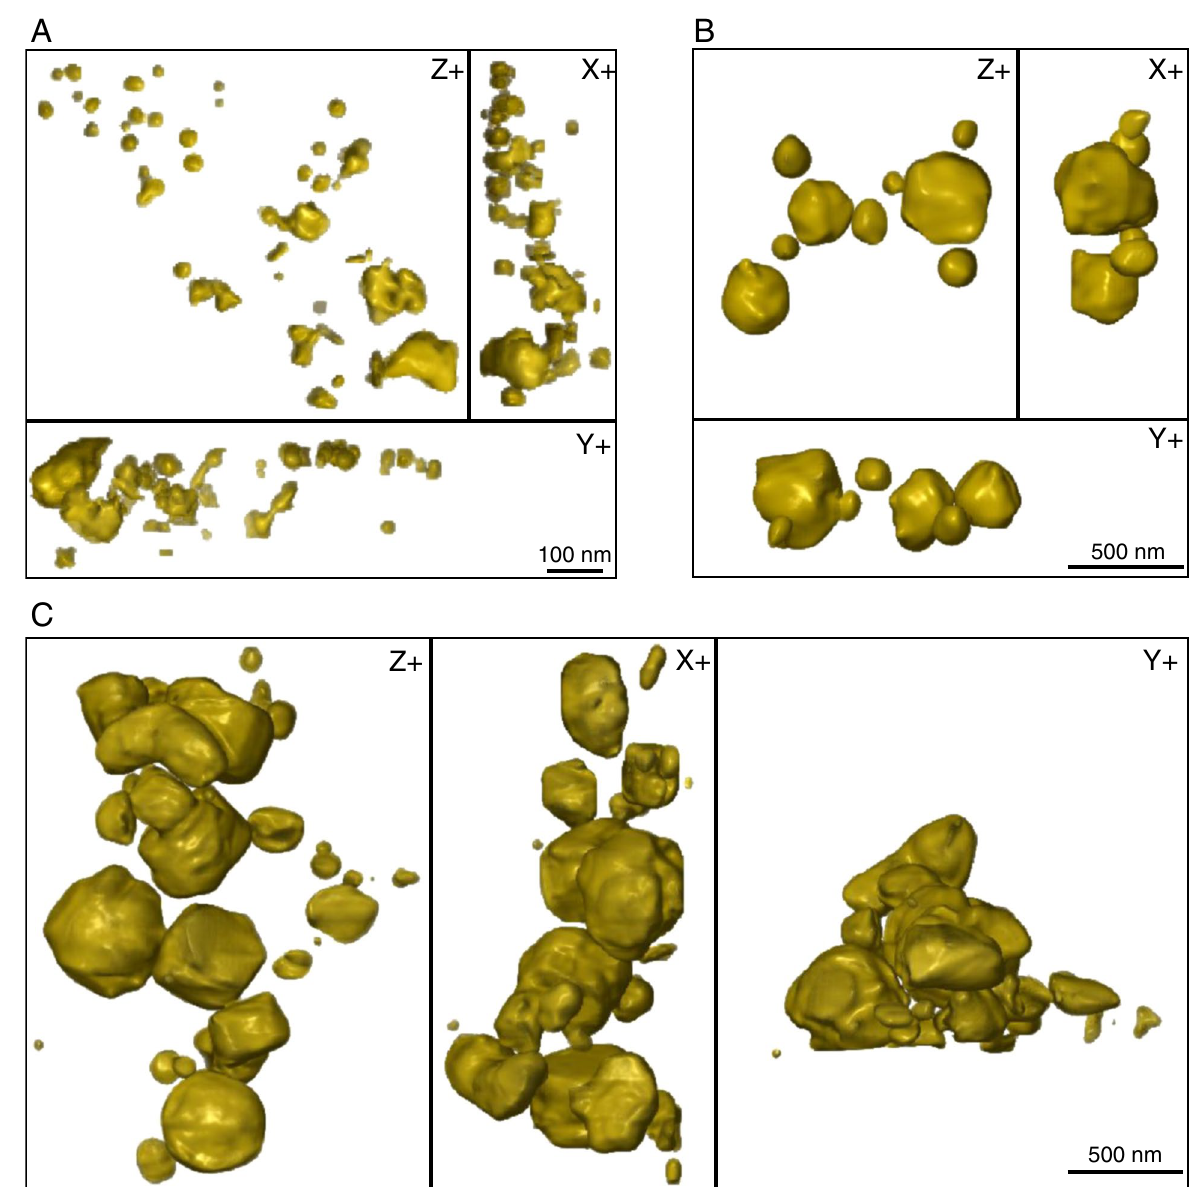
Figure 4. ( A ) Tomographic reconstruction of Fe-bearing particles from 180,487–86, viewed in three different planes: X, Y and Z. ( B ) Tomographic reconstruction of a different region showing relatively finer grain size fractions. ( C ) Rounded particles showing a range of different